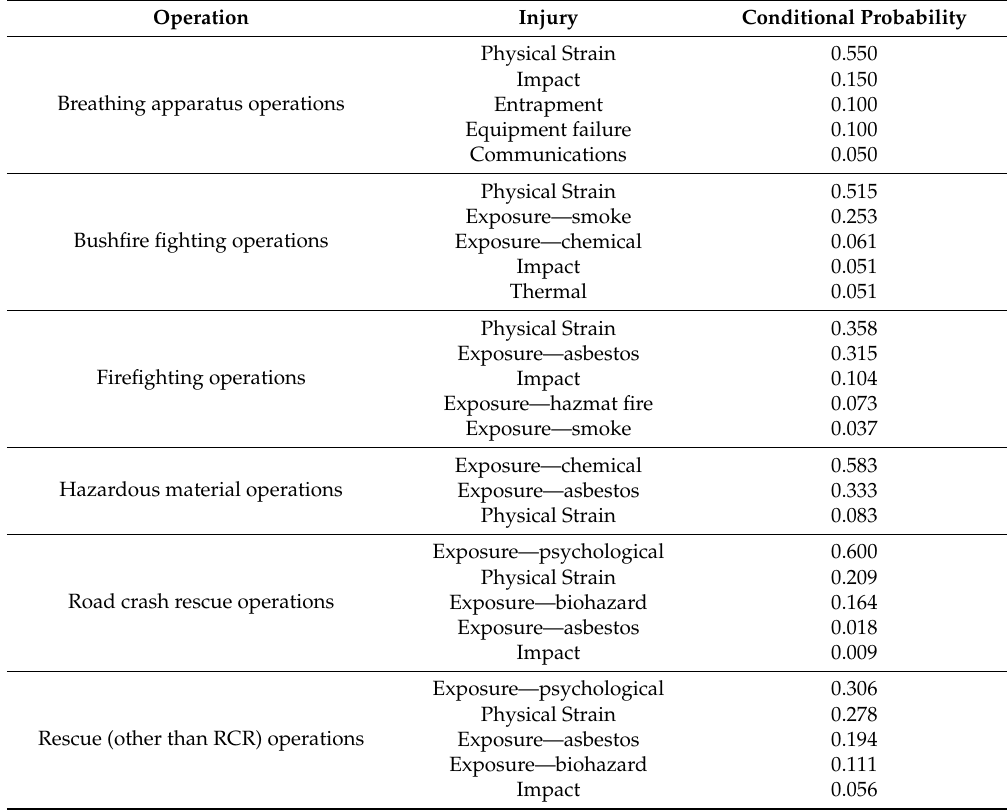
Table 5. Conditional probability of specific initiating events (risk sources) during incident